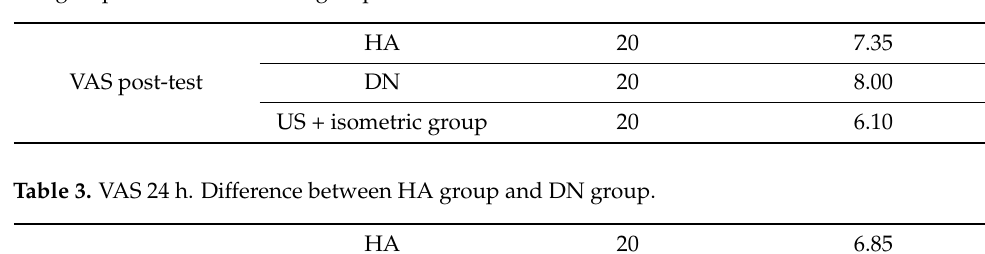
Table 2. VAS post-test. Difference between HA group and US + isometric group. Difference between DN group and US + isometric group.